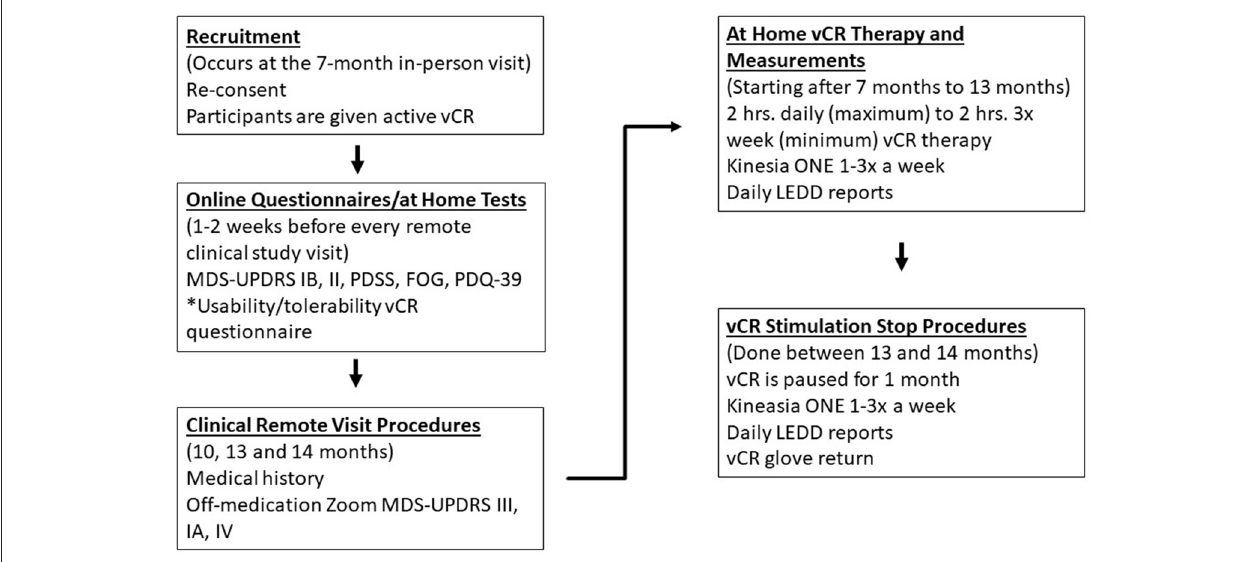
FIGURE 4 | Depicts study 2 remote procedures that detail vCR dosing techniques and clinical data obtained. At the 7-month in-person visit, patients will be reconsented and will be sent home with active vCR. Patients will be instructed to stimulate between 2h a day (maximum) to 2h three times a week (minimum) from months 7 to 13, report their LEDD amount and perform the Kinesia ONE motor assessment one to three times a week to monitor motor ability throughout the entire trial. One to two weeks before every remote study visit, patients take the following questionnaires: MDS-UPDRS IB, II, PDSS, FOG, PDQ-39, and the Usability/Tolerability vCR device questionnaire. Remote study visits occur at 10, 13 months, and after a 1 month (14th month) pause in stimulation to assess long-lasting effects. During these remote study visits, patients are off medication and the study’s treating neurologist gathers medical history and the study’s main movement disorders evaluator assesses the remote MDS-UPDRS III, IA, and IV. *The Usability/Tolerability questionnaire is performed 1 week after the start of therapy and then 1–2 weeks before every study